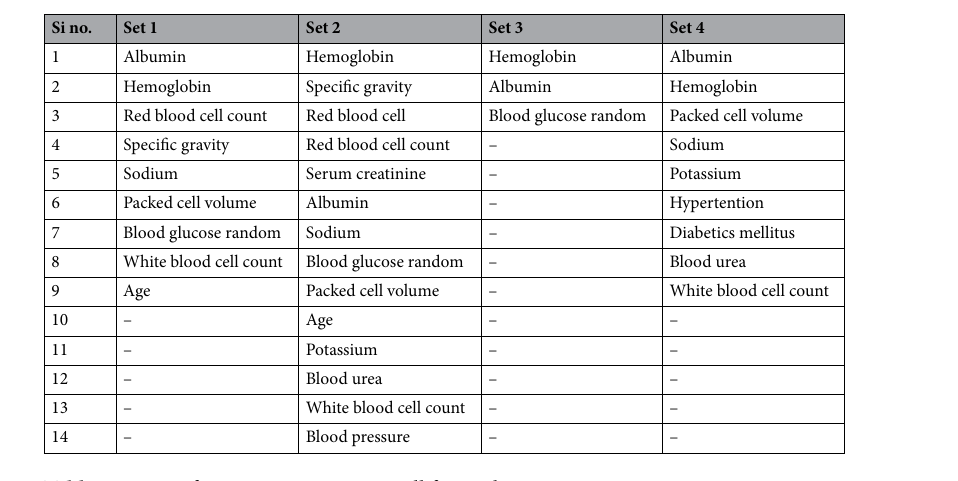
Table 9. SHAP features importance on all four subsets.